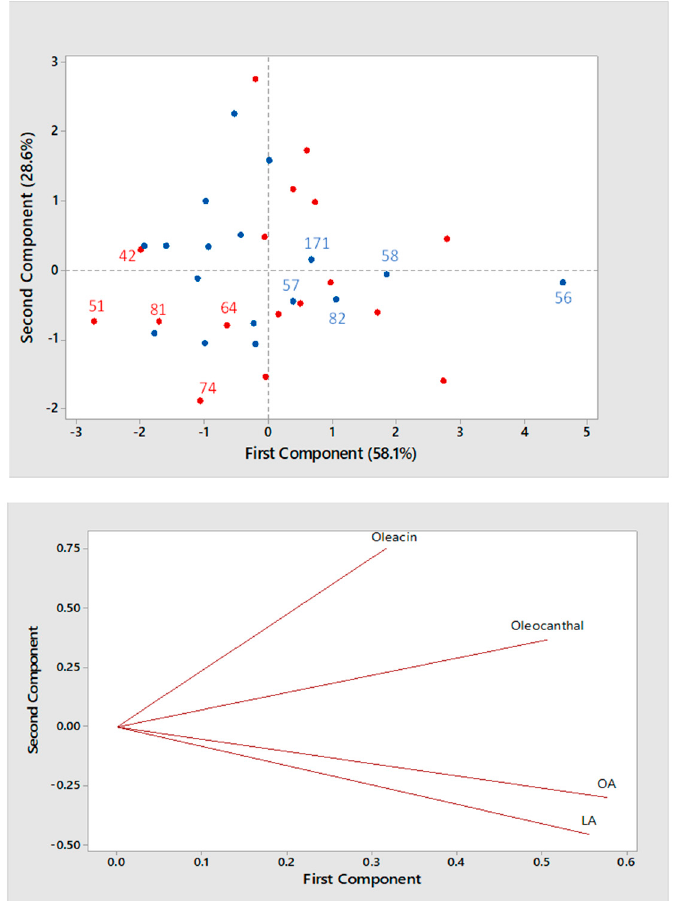
Figure 7. Score plot ( top panel ) and Loading plot ( bottom panel ) referred to the first two components provided by Principal Components Analysis (PCA) based on average normalized peak areas obtained for OA, LA, oleacin and oleocanthal (including the contribution of their carboxylic derivatives, if present) after the RPLC-ESI(-)-FTMS analysis of two replicated extracts for each of 34 Italian EVOOs produced during the 2017/2018 campaign. Olive oils produced using a three- or a two-phase decanter are indicated by blue and red dots, respectively. The sample numbering for emphasized samples is the same adopted in Table 1.